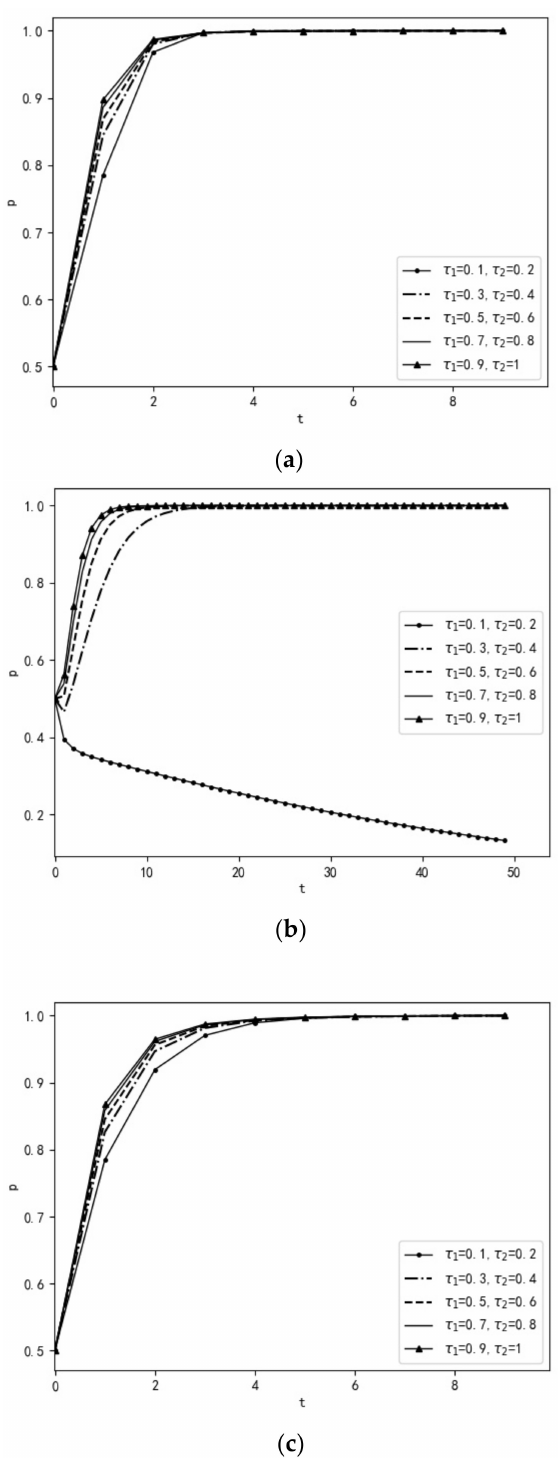
Figure 7. The impact of the topic derivative rate on tripartite strategy evolution. ( a ) The impact of the topic derivative rate on the local government. ( b ) The impact of the topic derivative rate on enterprises. ( c ) The impact of the topic derivative rate on the